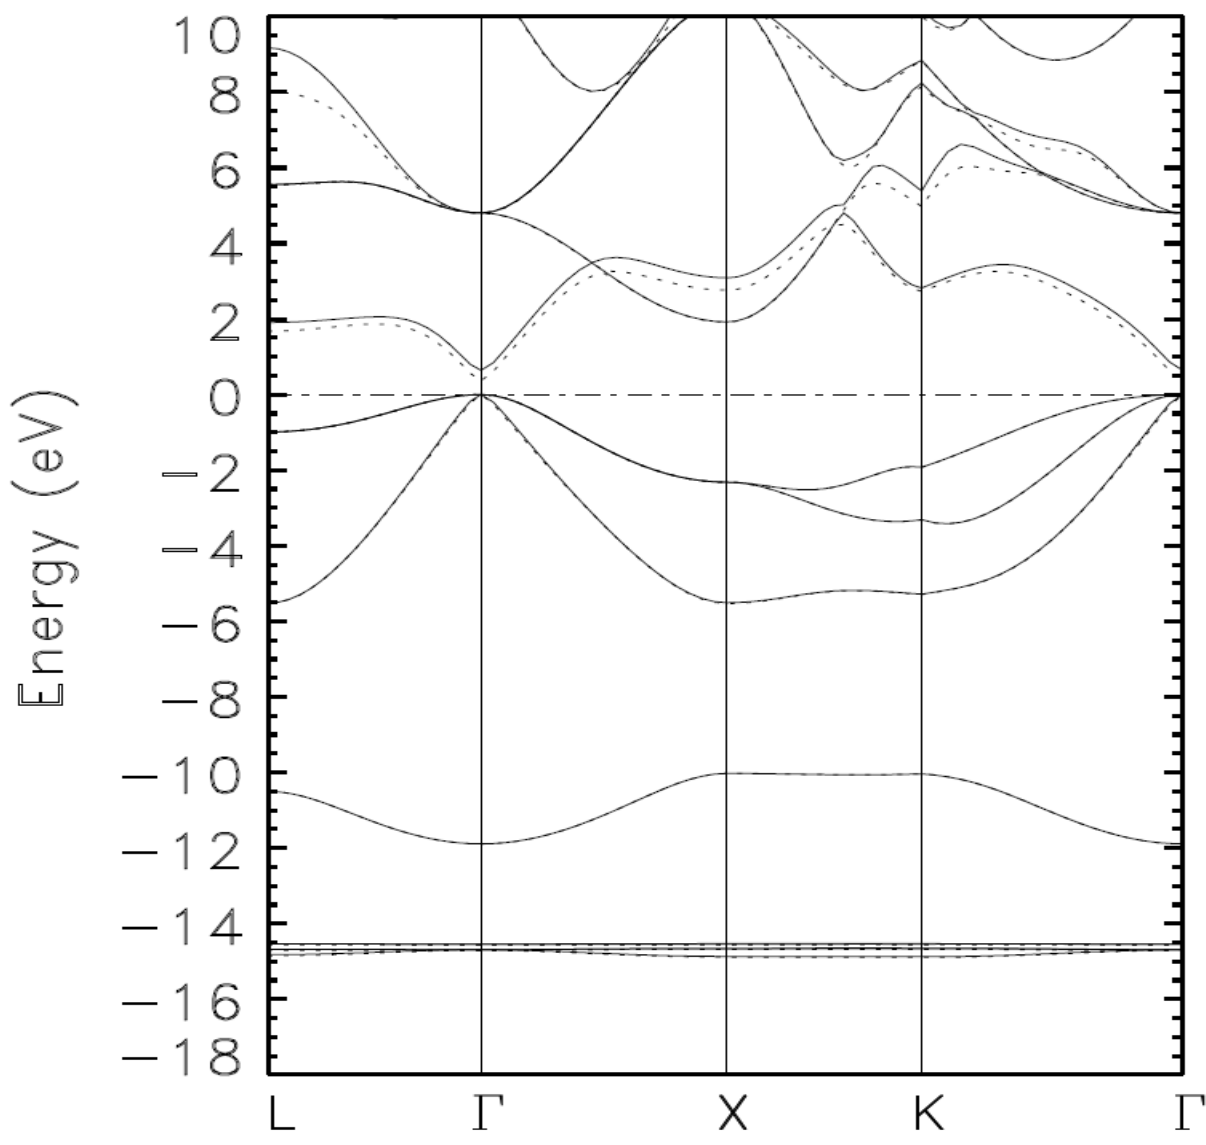
Figure 3. Calculated band structure of zinc blende indium arsenide (zb-InAS) obtained by the BZW method from calculations III (full line) and IV (dashed line).